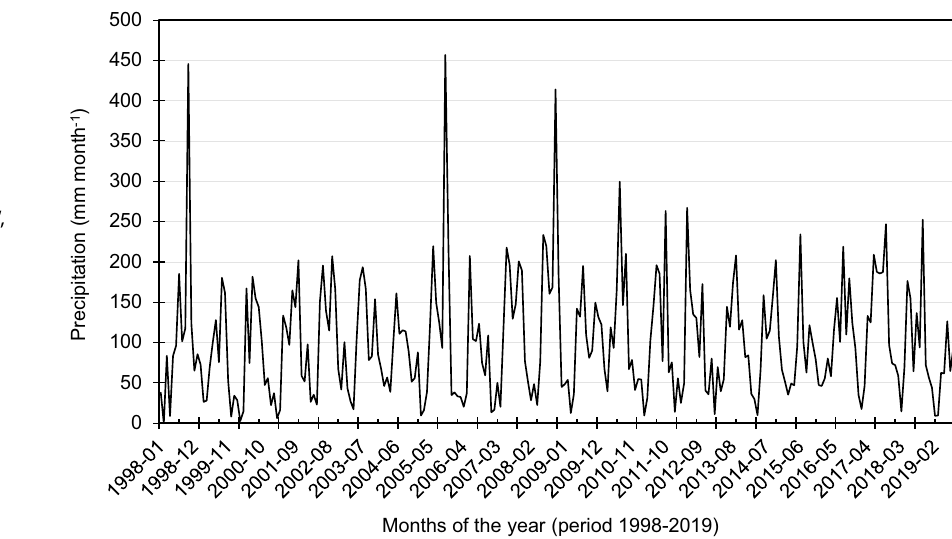
Fig. 5 Mean Monthly Pre- cipitation Time Series Period 1998–2019. Time series, area-averaged